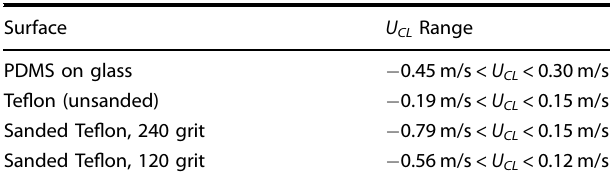
Table 5. Davis – Hocking model limits: range of U CL values that produce a valid dynamic contact angle where 0 ∘ ≤ θ ≤ 180 ∘ for the parameter values presented in Table